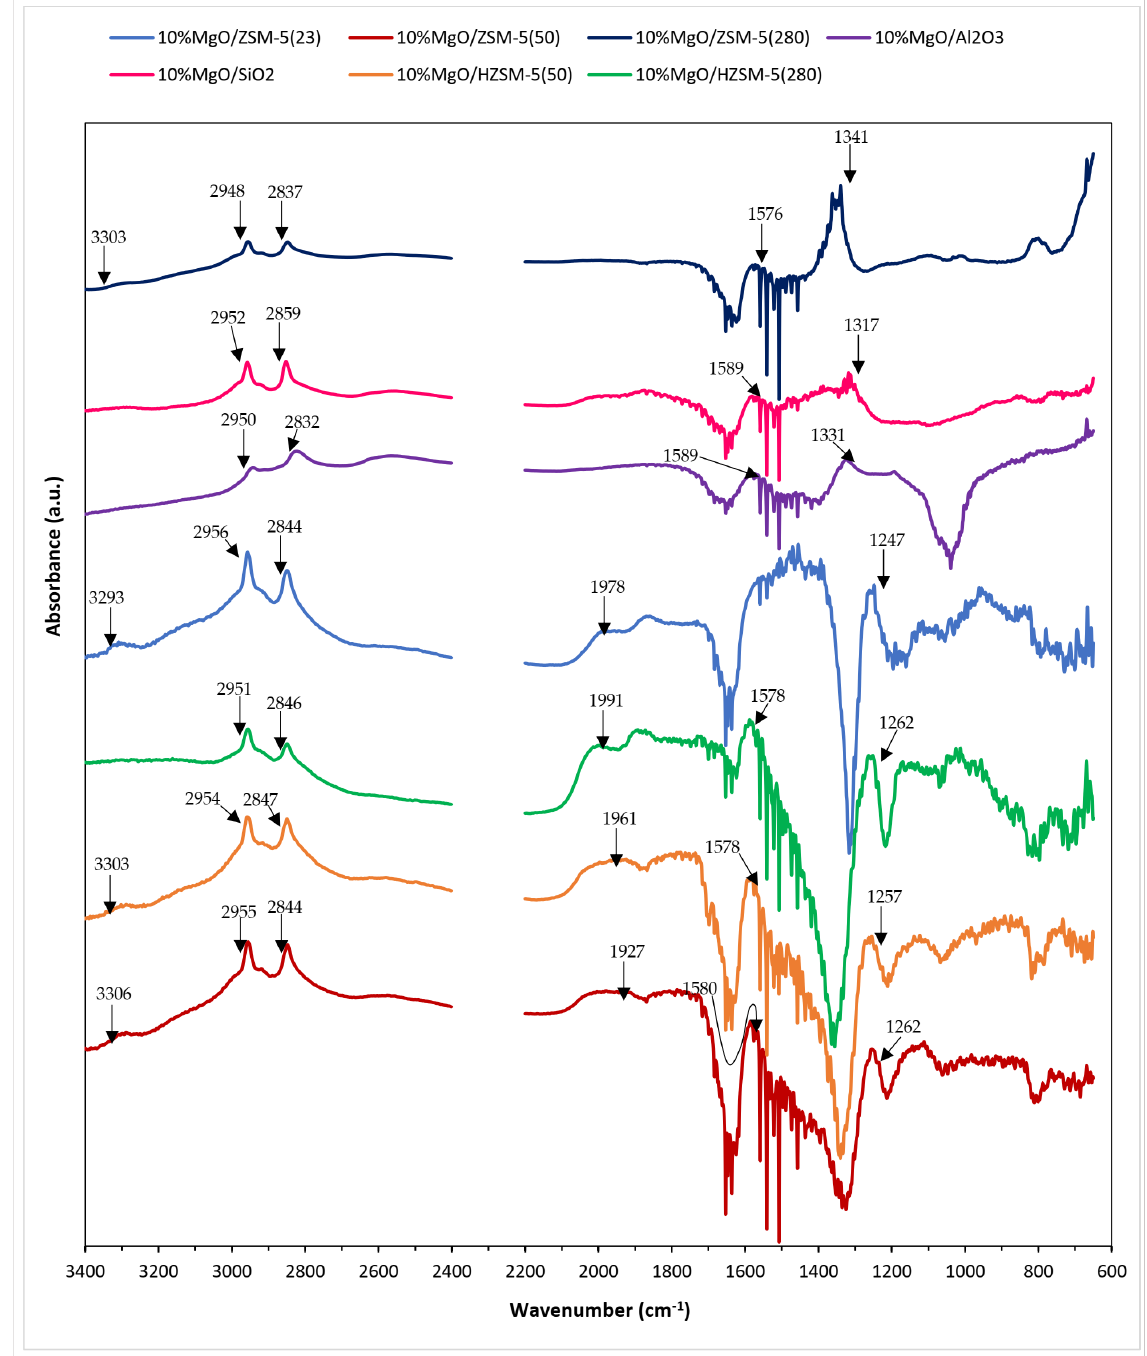
Figure 4. FTIR difference spectra of adsorbed species taken after exposure of the catalytic system (10% MgO/Al 2 O 3 , 10% MgO/SiO 2 , 10% MgO/ZSM-5 and 10% MgO/HZSM-5) calcined in an air atmosphere at 500 ◦ C for 4 h, to a mixture of 6 vol% methanol–94% argon mixture at 50 ◦ C and after the evacuation of this mixture for 10 min using argon stream. The ratio of silicon to aluminum is given in